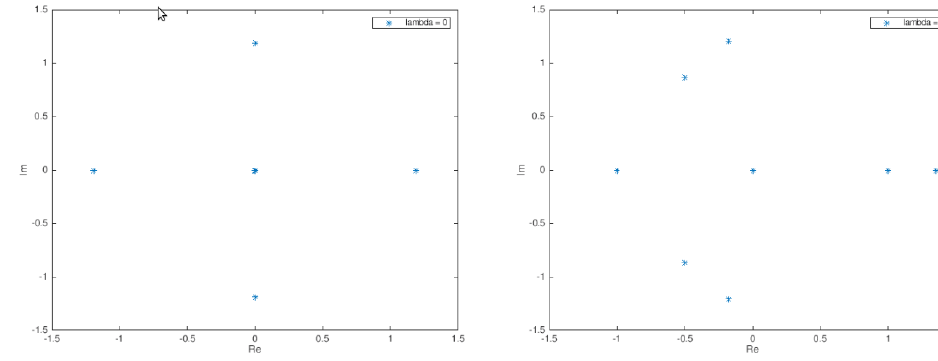
Figure 6. Eigenvalues of the matrix A for λ = 0 and λ = 1.